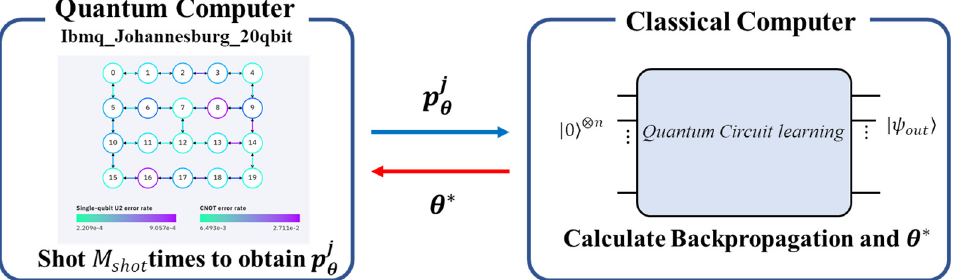
Figure 9. Implementation architecture of error backpropagation-based quantum circuit learning on the real NISQ devices. The node color depicted in the left-side circuit denotes the noise